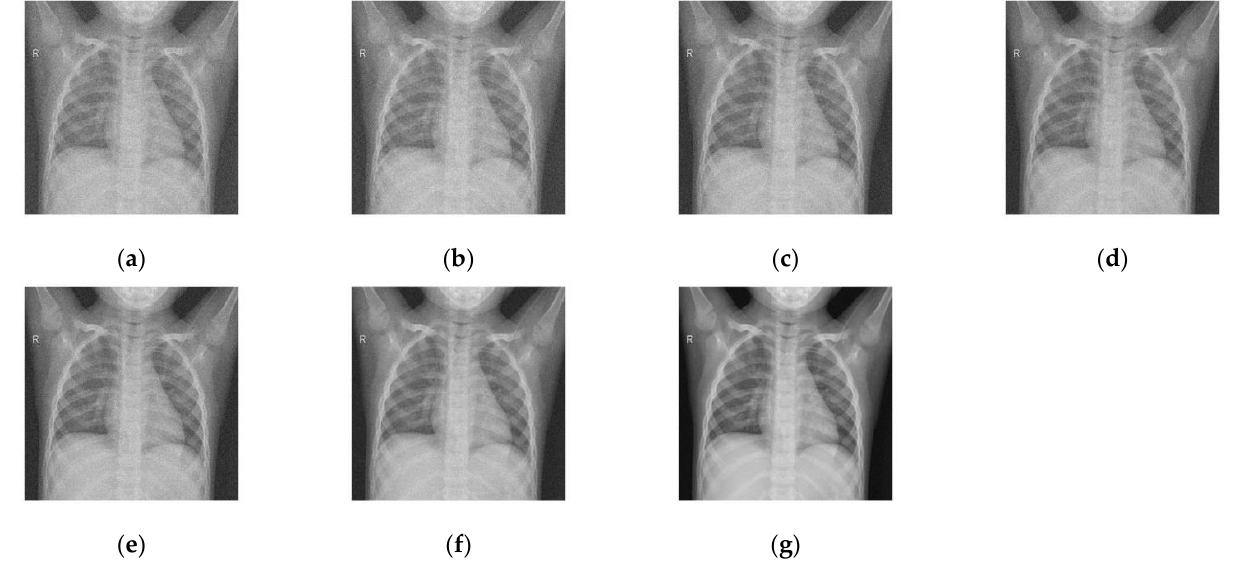
Figure 7. Results of CT image denoising, ( a ) Outcomes of Mingliang et al., 2016 [5]; ( b ) outcomes of Kuppusamy et al., 2019 [7]; ( c ) outcomes of Cheng et al., 2019 [10]; ( d ) outcomes of Zhao et al., 2019 [11]; ( e ) outcomes of Jomaa et al., 2018 [13]; ( f ) outcomes of Manoj and Singh, 2020 [14]; ( g ) outcomes of proposed method.